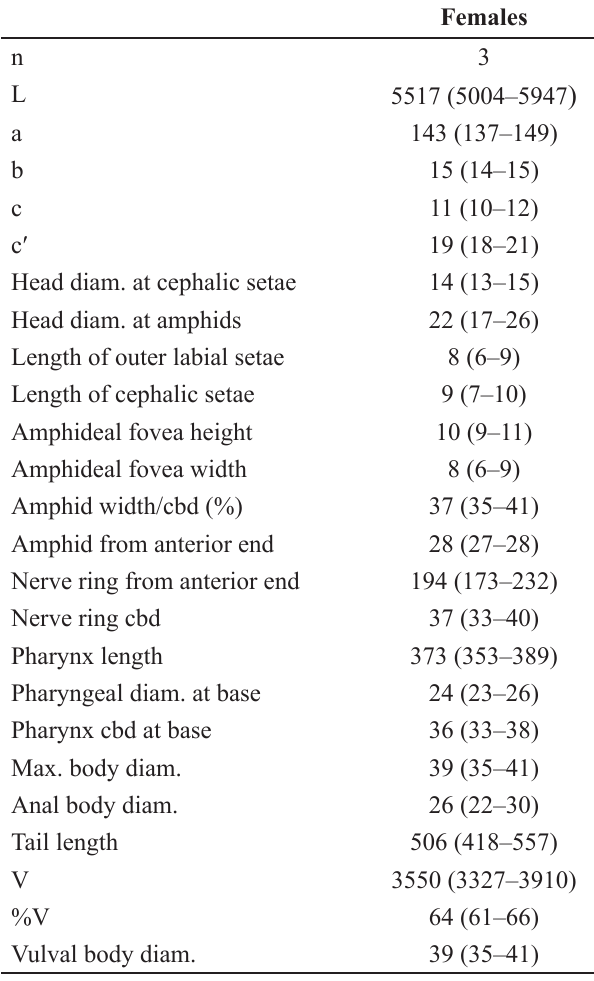
Table 1. Morphometrics (μm; mean (range)) of female Trefusialaimus idrisi Leduc, 2013 from the continental slope of New Zealand. Abbreviations see Material and